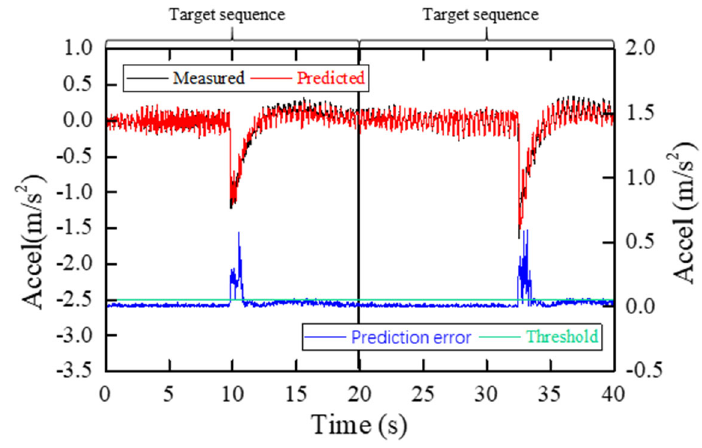
Figure 14. An example of anomaly detection with proposed